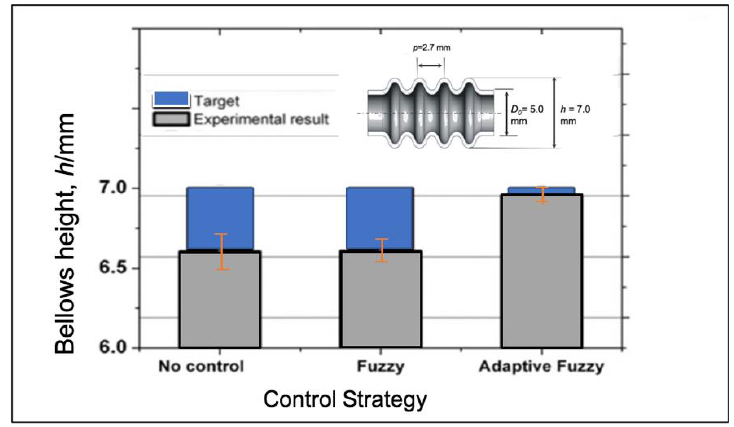
Figure 18. Comparison between the bellows height accuracy and its variation under different control strategies.